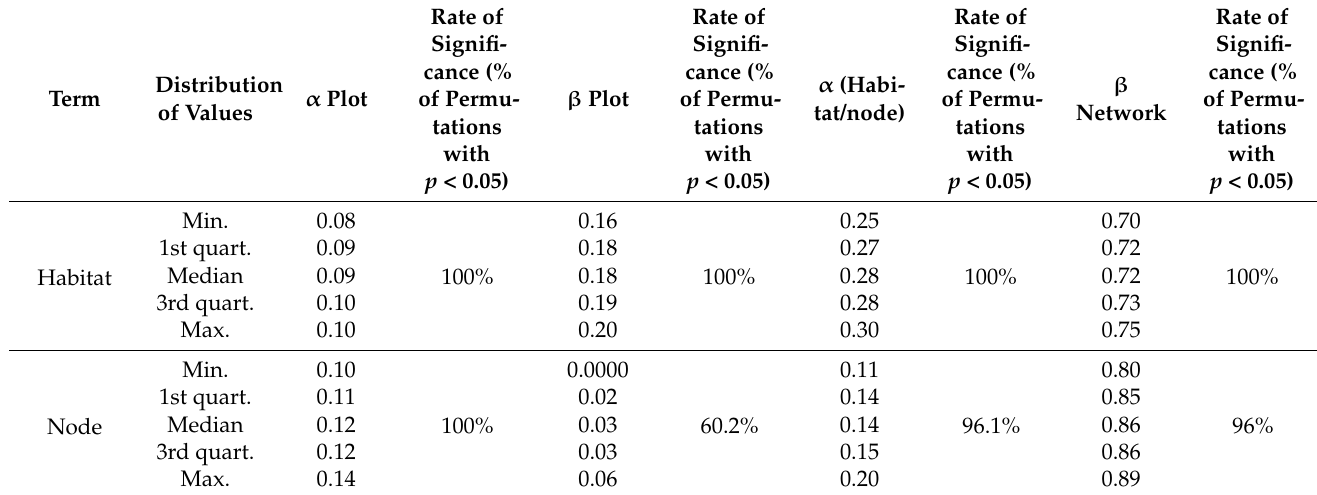
Table 2. Summary statistics of additive partitioning results showing the differences in species richness ( α ) at plot and habitat/node level vs. dissimilarity ( β ) at plot and network level derived from 999 stratified resampling of the original dataset based on the plot numbers given by the decay of habitats MultSE and from 999 random resampling of the original dataset based on the plot numbers given by the decay of whole EN MultSE .